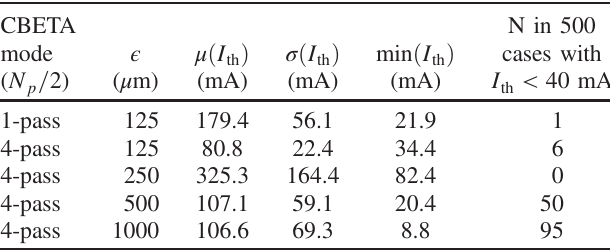
statistics of different th th